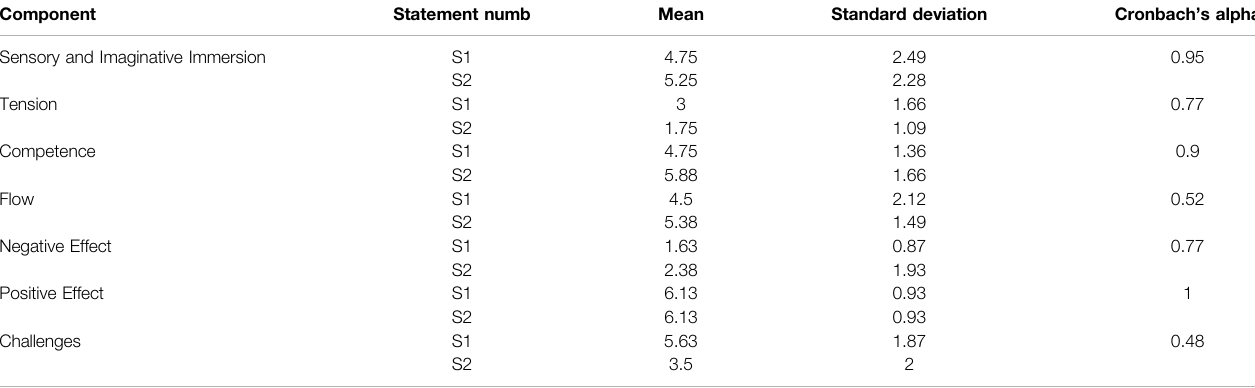
TABLE 6 | Report of mean and standard deviation for each question item in GEQ along with Cronbach ’ s alpha for each component.